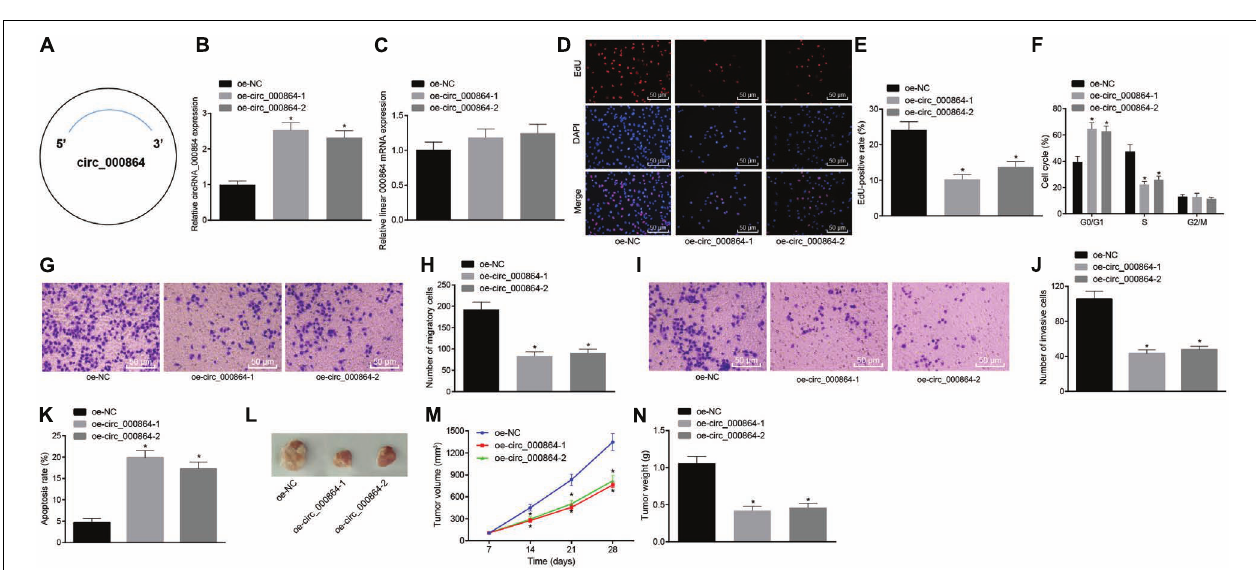
FIGURE 3 | CircRNA_000864 upregulation results in suppression of pancreatic cell proliferation, migration, invasion, and antiapoptosis. AsPC-1 cells were transfected with oe-NC, oe-circRNA_00086-1, or oe-circRNA_00086-2. (A) A simple structure diagram of circRNA_000864. (B) CircRNA_000864 expression in AsPC-1 cells detected by RT-qPCR assay normalized to GAPDH. (C) Linear RNA_000864 expression in AsPC-1 cells by RT-qPCR normalized to GAPDH. (D,E) Proliferation of AsPC-1 cells detected by 5-ethynyl-2 (cid:48) -deoxyuridine (EdU) assay ( × 200). (F) Cell cycle distribution in AsPC-1 cells detected by flow cytometry. (G,H) Migration in AsPC-1 cells detected using Transwell assay ( × 200). (I,J) Invasion in AsPC-1 cells detected by Transwell assay ( × 200). (K) Apoptosis in AsPC-1 cells detected by flow cytometry. Mice were treated with oe-NC, oe-circRNA_00086-1, or oe-circRNA_00086-2. (L) Representative images of xenograft tumor formation in nude mice ( n = 6). (M) Tumor volume of mice ( n = 6). (N) Tumor weight of mice ( n = 6). * p < 0.05 vs. AsPC-1 cells transfected with oe-NC. The above data were all measurement data. The statistical results of (M,N) were expressed as sample mean ± standard deviation. (M) was analyzed by repeated measurement ANOVA (Tukey’s post hoc test), and (N) was analyzed by ANOVA (Tukey’s post hoc test). The rest of the data were expressed as sample mean ± standard error. The cell experiment was conducted three times